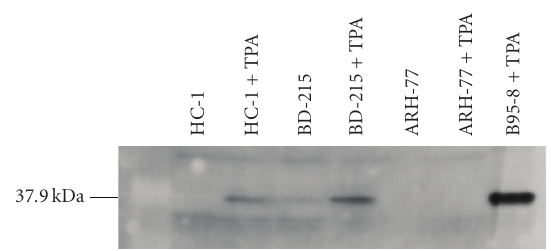
Figure 2: Detection of ZEBRA protein in EBV + cell lines. Western blot analysis with antibodies raised against ZEBRA shows that ZEBRA can be induced in the cell line HC-1 and that the cell line BD-215 can be stimulated to increase the expression of the immediate early protein. Expression in ARH-77 could not be induced by TPA during 72hours. TPA-stimulated B95-8 was used as control for the expression of